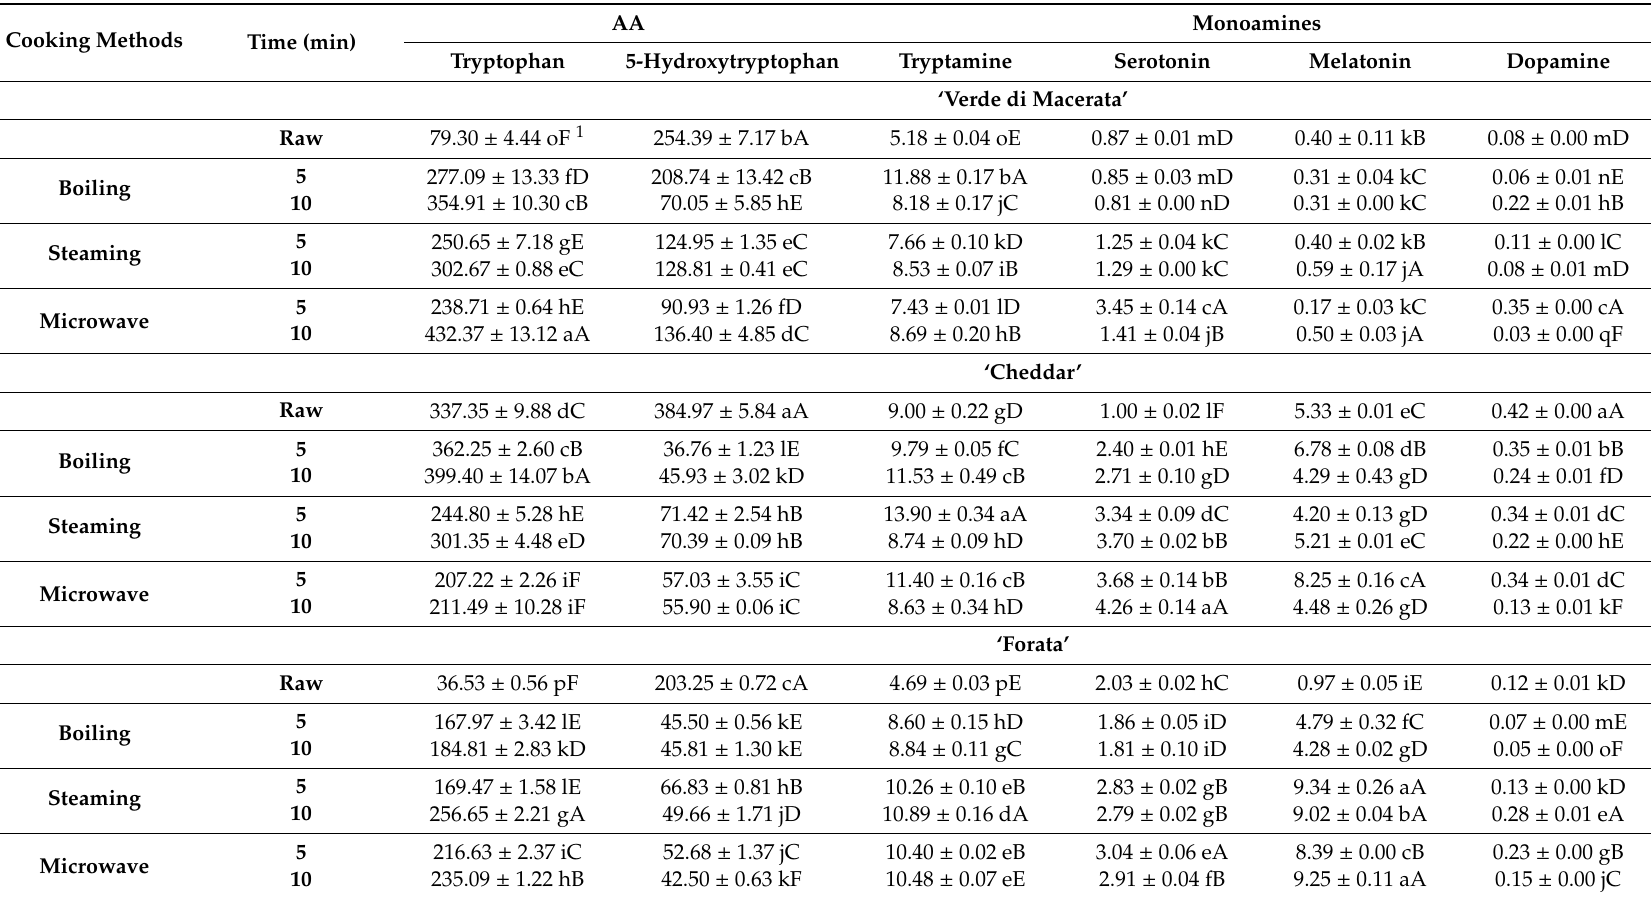
Table 1. Amino acids (AA) and biogenic amines content (ug / g d.w.) in colored cauliflowers raw and thermally